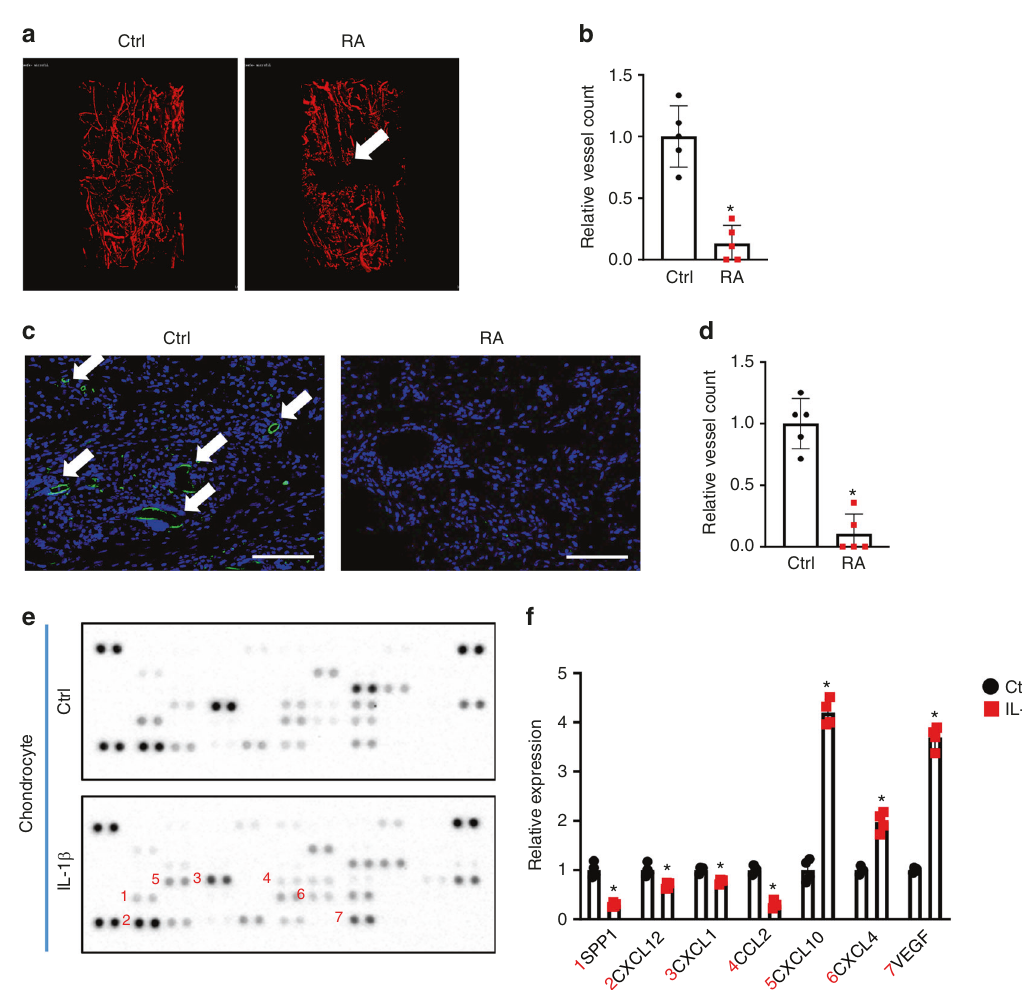
Fig. 2 Systemic in fl ammation led to impaired angiogenesis. a MicroCT assessment of newly formed vessels within 10 dpf fracture calluses from control and RA mice. b Quanti fi cation of vessel counts in 10 dpf control and RA fracture calluses ( n = 5) based on microCT assessment. The results were normalized to the controls. * P < 0.05 compared with control by Student ’ s t test. c Immunohistochemical staining for endomucin in 10 dpf fracture calluses from the control and RA mice. d Quanti fi cation of vessel counts in 10 dpf control and RA fracture calluses ( n = 5) based on the immunohistochemical assessment. The results were normalized to the controls. * P < 0.05 compared with control by Student ’ s t test. e Representative images of an angiogenesis proteasome array from the culture medium of chondrocytes following vehicle and IL-1 β treatment. f Quanti fi cation of blot intensity from the angiogenesis proteasome array ( n = 4). All results were normalized to the controls. * P < 0.05 compared with control by Student ’ s t test. Scale bar, 200 μ of human umbilical vein endothelial cells (HUVECs) using culture medium supernatants collected from primary chondrocytes treated with vehicle or IL-1 β (Fig. 3c – e). Consistent with our in vivo fi ndings on angiogenesis, the control culture supernatants from vehicle- treated chondrocytes exhibited robust cell migration as well as an abundance of well-developed vessel tubes in vitro. In contrast, signi fi cant reductions in HUVEC migration, tube number, and tube length were observed in the presence of culture supernatant from IL-1 β -treated chondrocytes. This was not related to the continued presence of IL-1 β in the supernatant, since our angiogenic factor protein array con fi rmed that there was no IL-1 β left in the culture medium after 72 h of IL-1 β treatment (Fig. 2e). In addition, compared to culture medium from vehicle-treated chondrocytes, culture medium from IL-1 β -treated chondrocytes did not clearly alter HUVEC proliferation or apoptosis (Fig. S6), suggesting that the decreased angiogenic capacity of the culture medium was at least partially attributed to reduced SPP1 and CXCL12 but not dysfunction of the HUVECs themselves. Therefore, based on our previous studies, we applied 500 ng·mL − 1 SPP1 and 100 ng·mL − 1